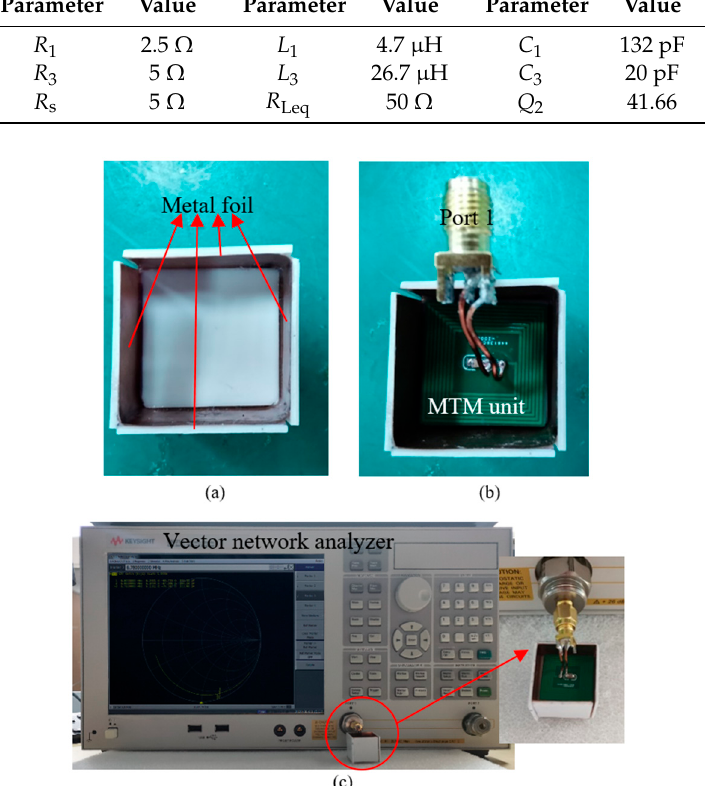
Figure 8. The proposed measurement setup ( a ) The PEC boundaries are made of metal foil with an MTM unit. ( b ) The MTM unit is added inside the boundaries. ( c ) Port 1 connects to the vector network analyzer to get the impedance parameters.